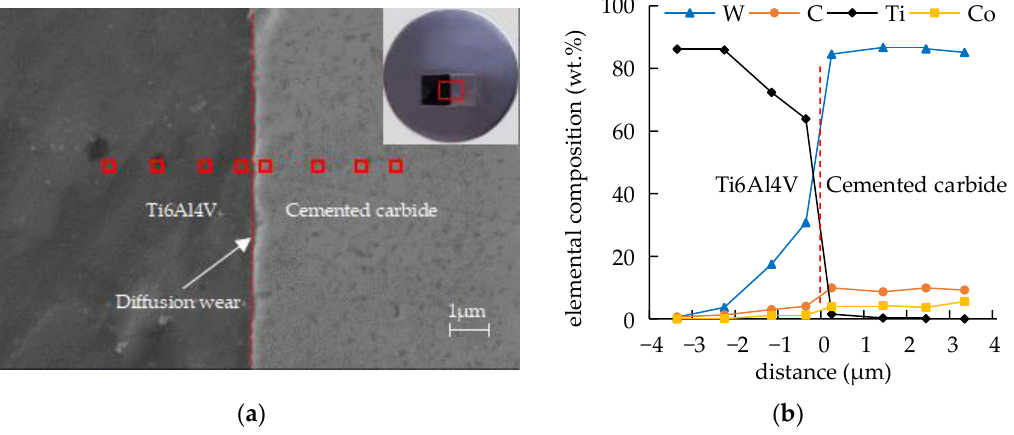
Figure 5. Element diffusion after 60 min of heating at 600 °C. ( a ) SEM images for the C0406 and the